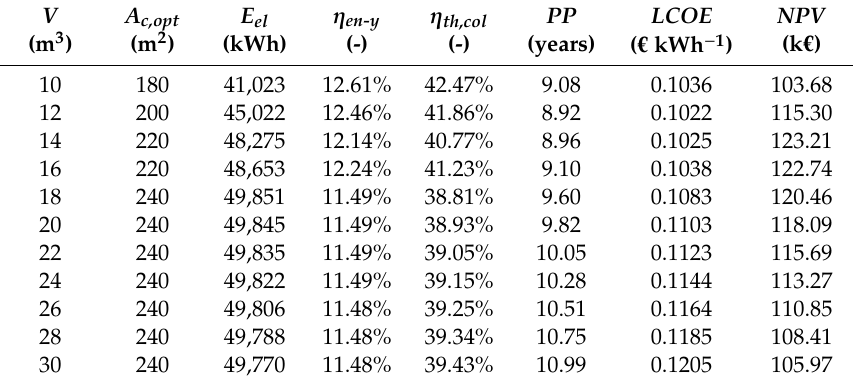
Table 6. Optimum collecting areas for di ff erent storage tank volumes for maximizing the net present